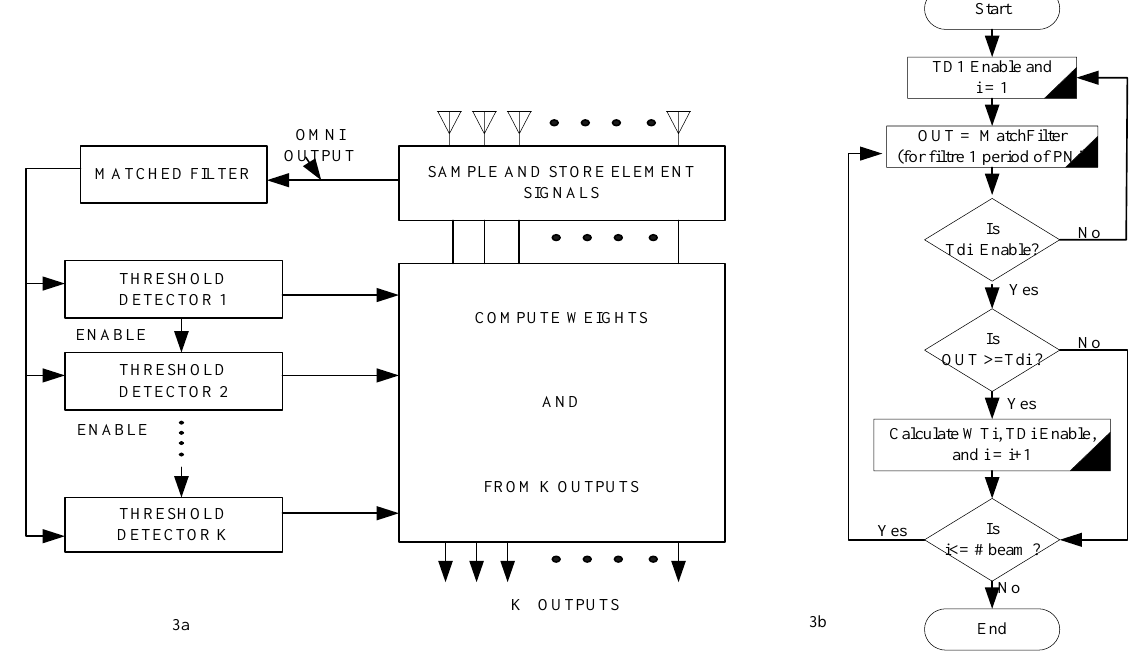
Figure 3. Flow chart and block diagram of MBAA and the signal acquisition signal processing